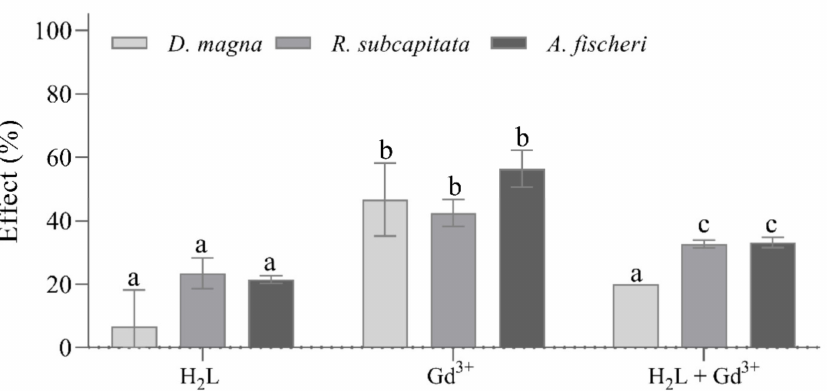
Figure 7. Results of ecotoxicity tests performed on A. fischeri, R. subcapitata, and D. magna exposed to 0.7 µ M harzianic acid, to 3.7 µ M gadolinium and to 3.7 µ M Gd 3+ + 0.7 µ M harzianic acid. Data are reported as mean ± SD ( n = 3). Letters (a–c) indicate significant differences between treatments; the level of significance was set at α = 0.05 (ANOVA). H 2 L = harzianic